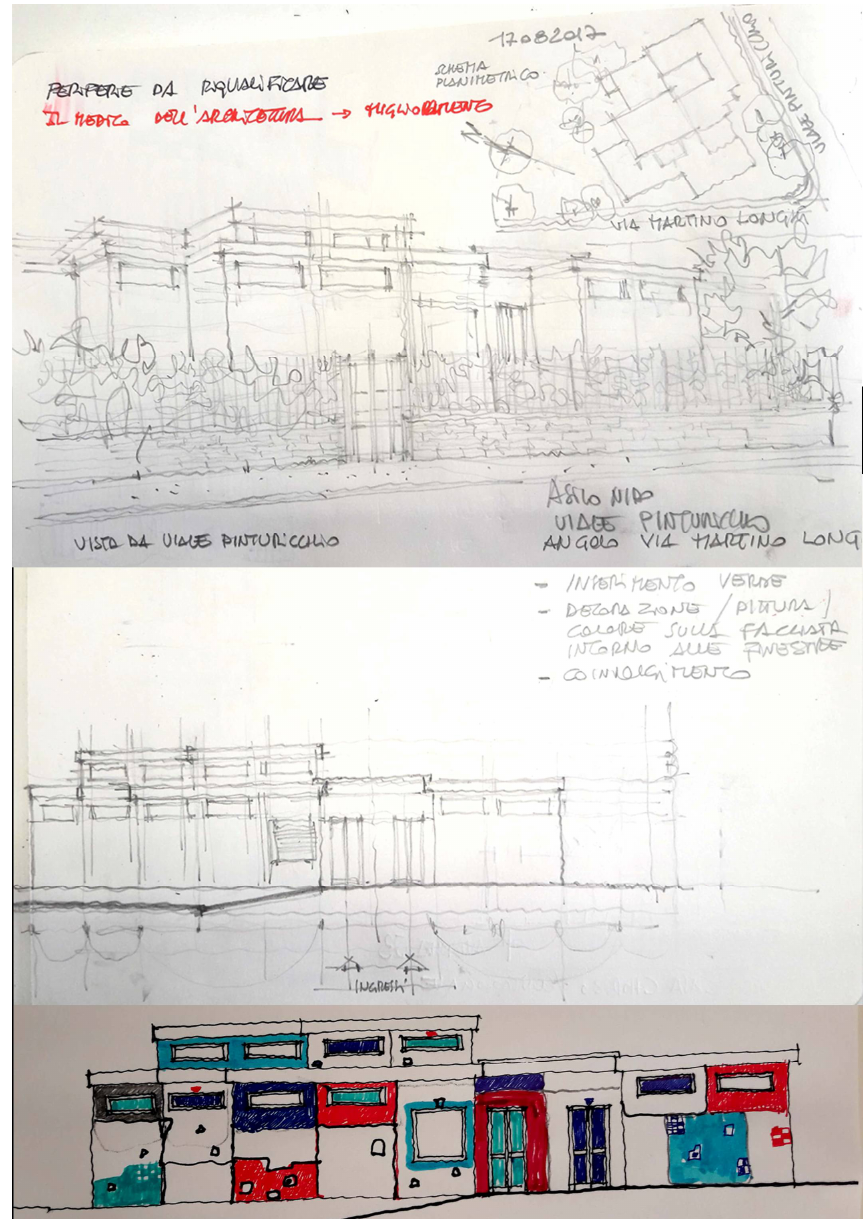
Figure 9. Graphic